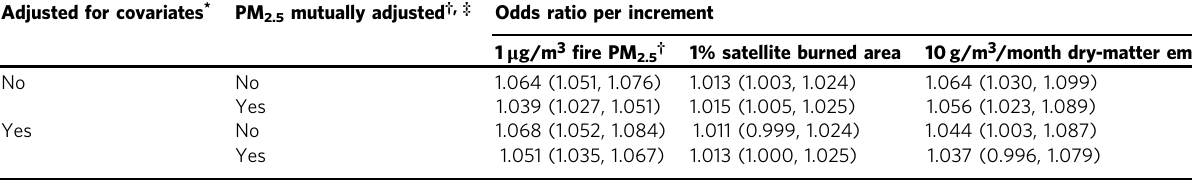
* The adjusted covariates included maternal age, temperature, humidity, and temporal trends. † Fire PM 2.5 and non- fi re PM 2.5 were estimated from CTM simulations. ‡ Fire PM 2.5 and non- fi re PM 2.5 were simultaneously incorporated into the regression